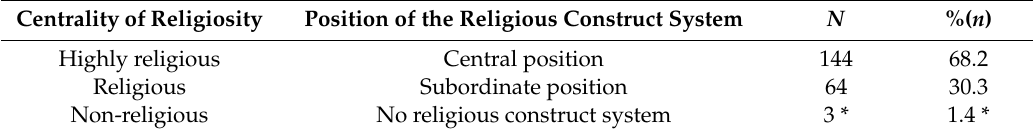
Table 2. Types of centrality of religiosity, position, and frequencies (t1, admission to clinic). Centrality of Religiosity Position of the Religious Construct System N %( n ) Highly religious Central position 144 68.2 Religious Subordinate position 64 30.3 Non-religious No religious construct system 3 * 1.4 * N = 211, * excluded from further analysis due to the small number of patients.